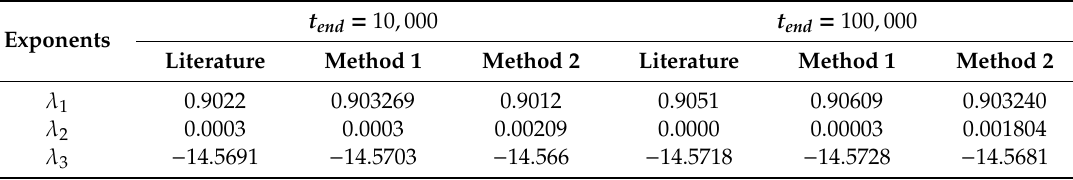
Table 1. Comparison of Lyapunov exponents (time is measured in